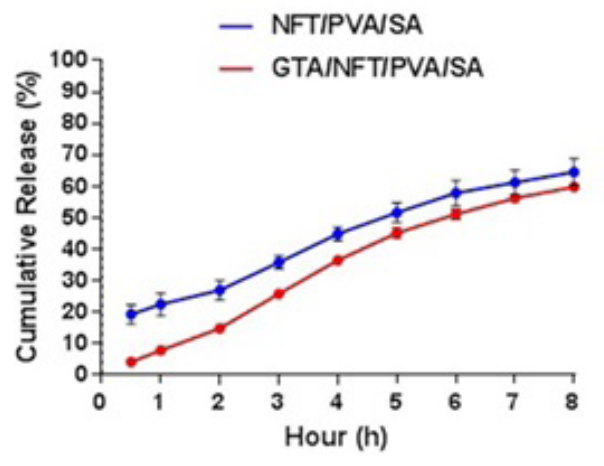
FIGURE 7 - Release profiles of NFT from NFT/PVA/SA and GTA/NFT/PVA/SA nanofibers.